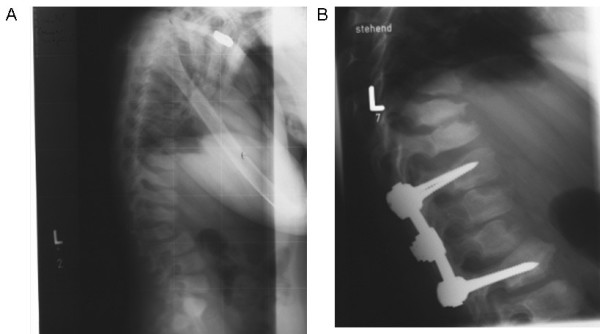
Radiography of kyphoscoliosis in alpha-mannosidosis before and after orthopedic correction. A. Kyphoscoliosis with skeletal abnormalities of all vertebrae. B. Orthopedic correction of kyphosis.